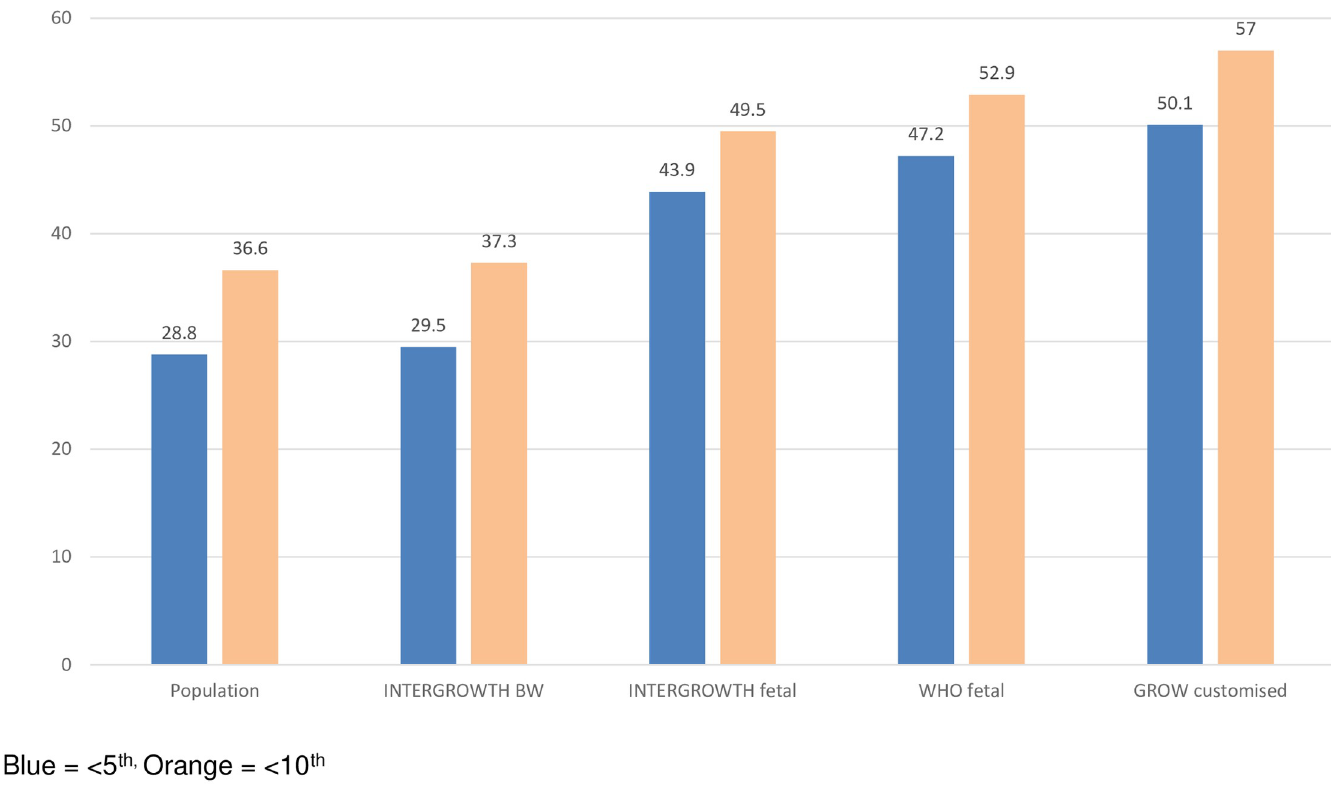
Fig 3. Proportion of all preterm stillborn infants ( n = 865) classified as < 5th or < 10th centile by each growth chart. BW, birthweight; GROW, Gestation Related Optimal